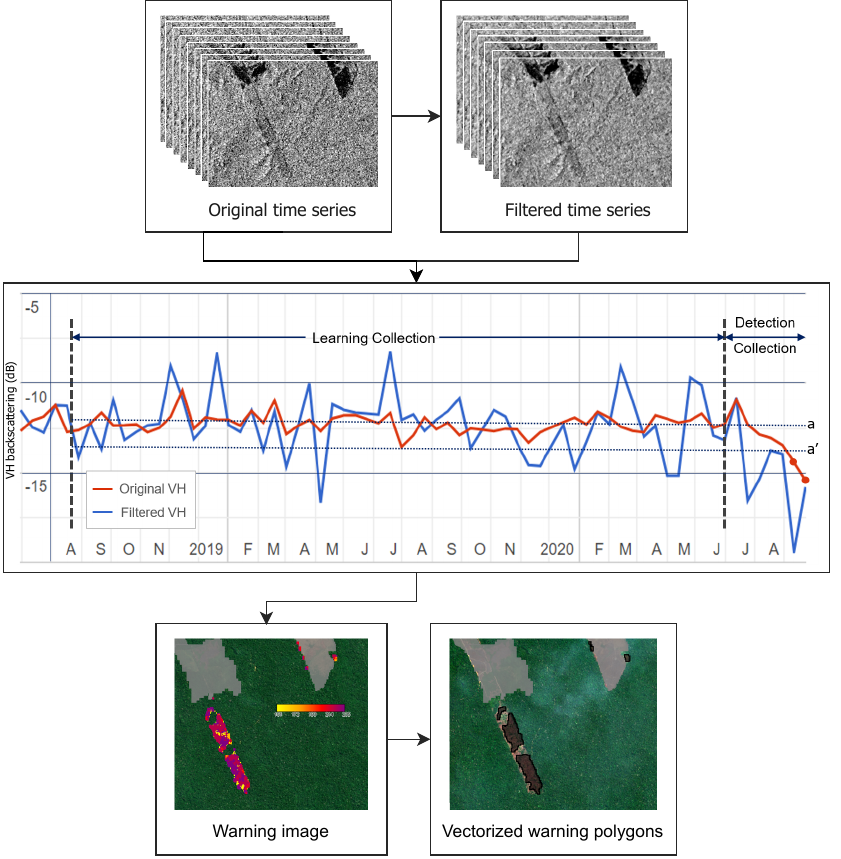
Figure 4. Detail of the warning detection procedure. Dotted lines a and a’ denotes the median value of the learning collection and the threshold value for a particular location, respectively. The red dots correspond to samples below the threshold, which will be flagged. Two flagged values on the detection collection implies on a confirmed